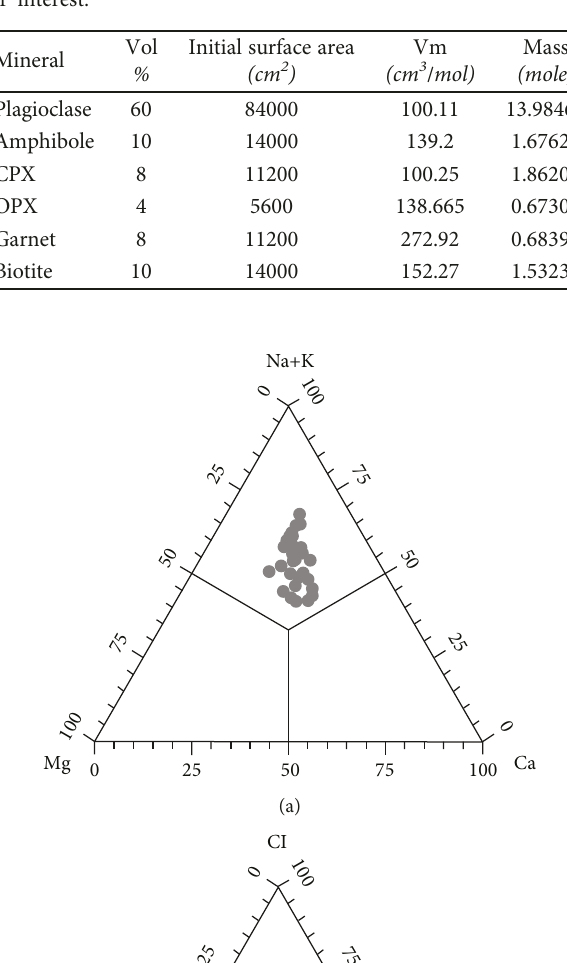
Table 3: Geometrical surface areas and masses of solid phases of interest.